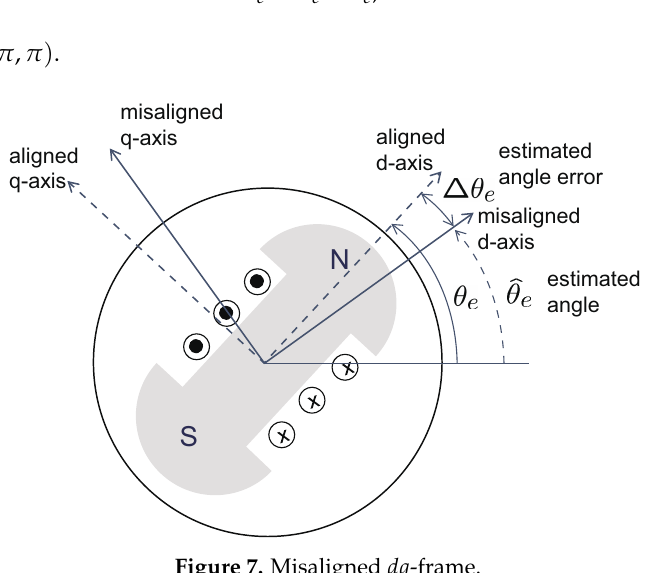
Figure 7. Misaligned dq